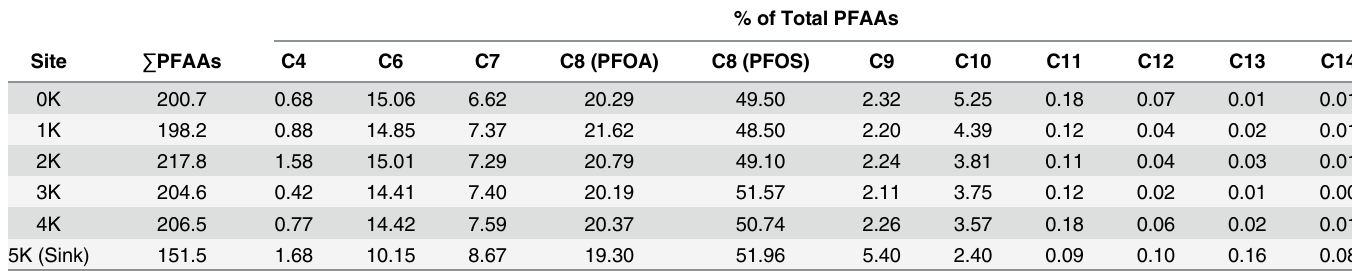
Table 2. Total concentrations (ng/L) and percent of total PFAAs determined in the water column during the wet season at various longitudinal points in Sweetwater branch